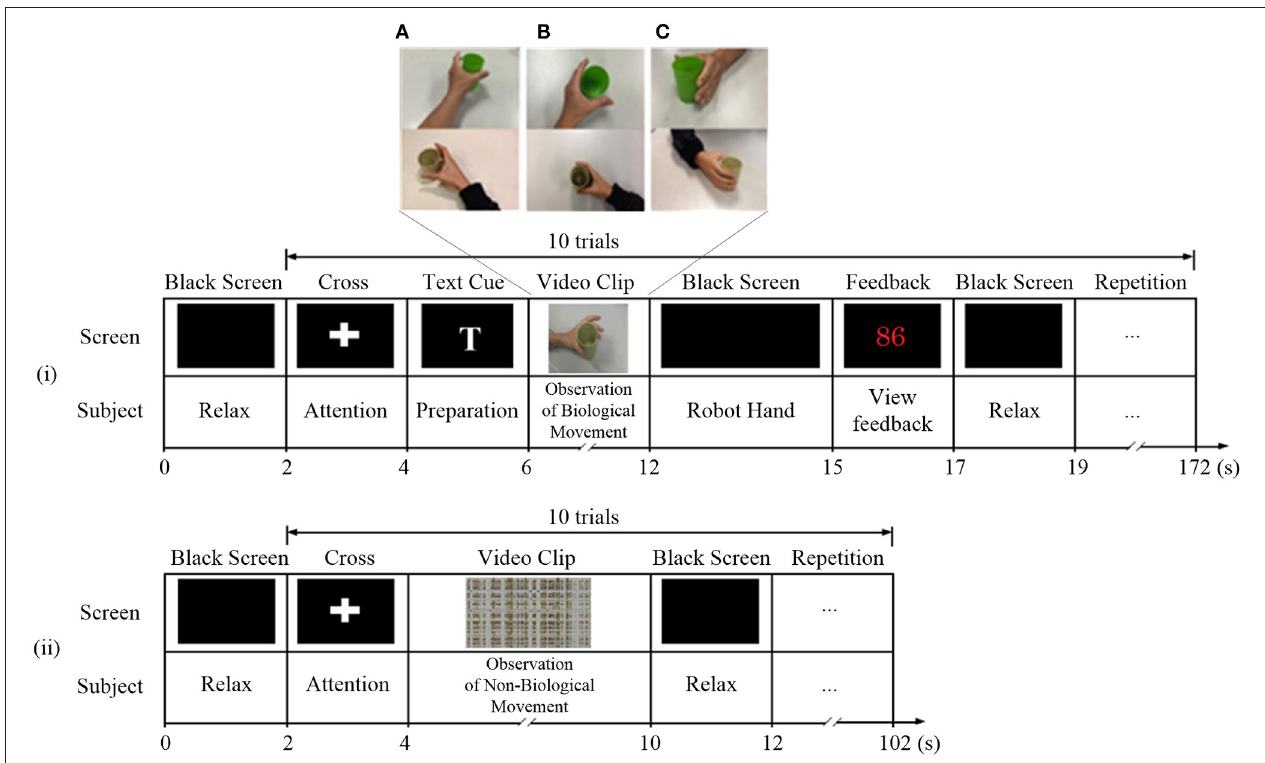
FIGURE 2 | Experiment paradigms for observation of (i) biological and (ii) non-biological movements. During the observation of biological movements, video clips were displayed in (A) egocentric, (B) overhead, and (C) allocentric perspectives.